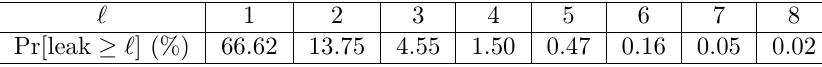
Table 3: Probability of recovering at least ‘ bits of k